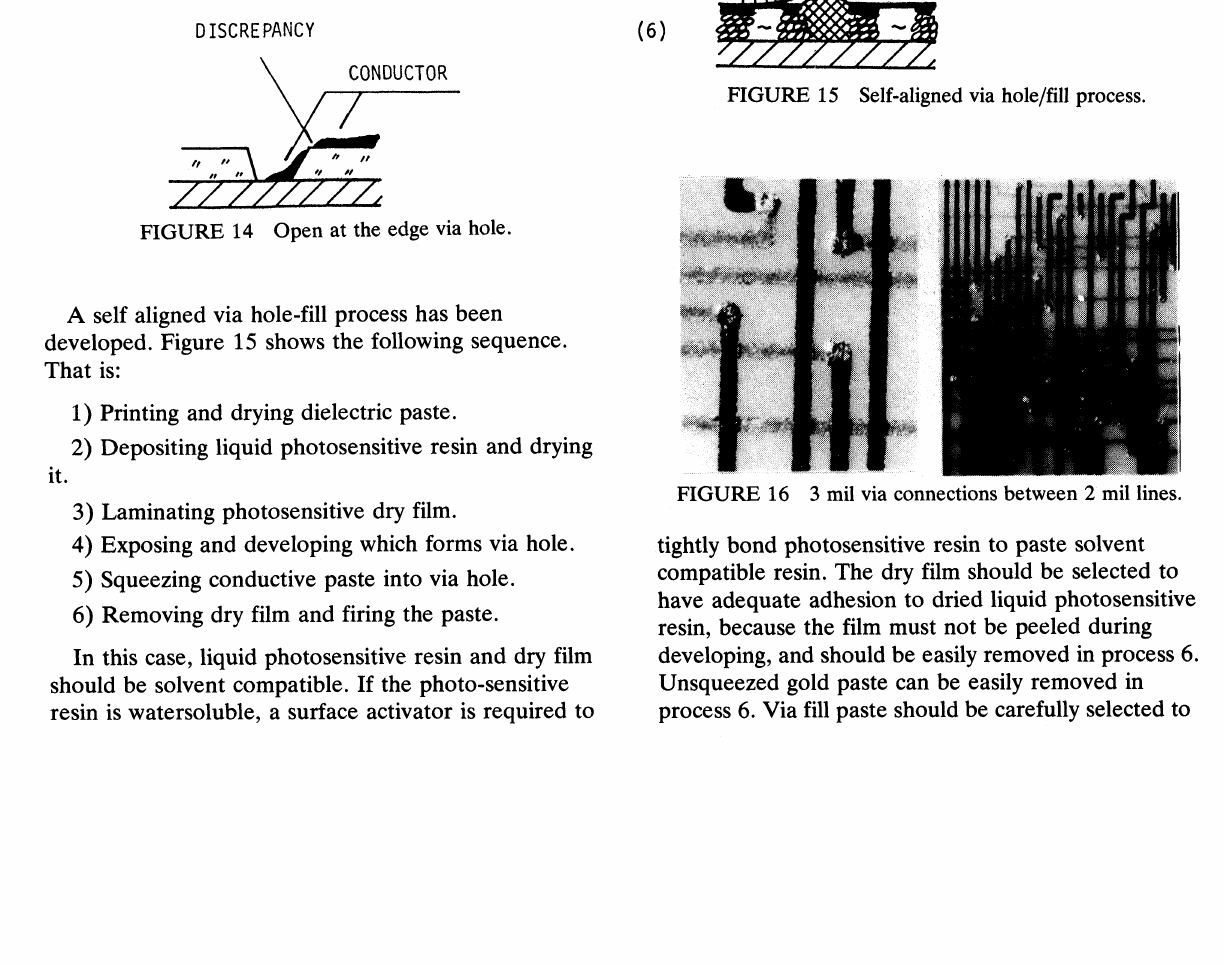
FIGURE 15 Self-aligned via hole/fill process.